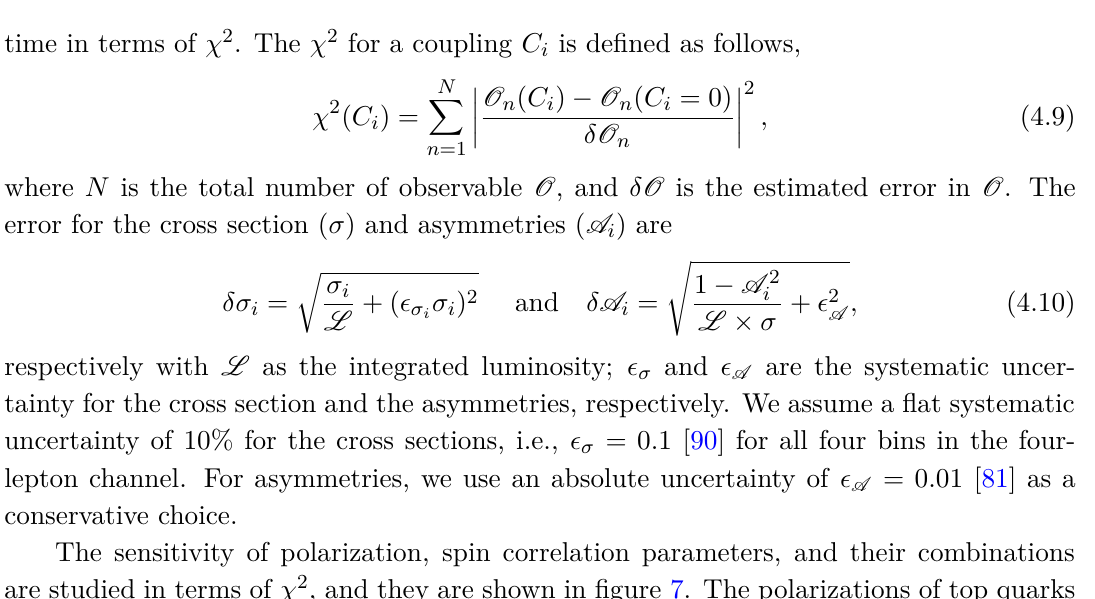
Figure 7 . Comparison of different polarizations and spin correlations and their combinations in terms of χ 2 as a function of t ¯ tZ anomalous couplings at L = 3000 fb − 1